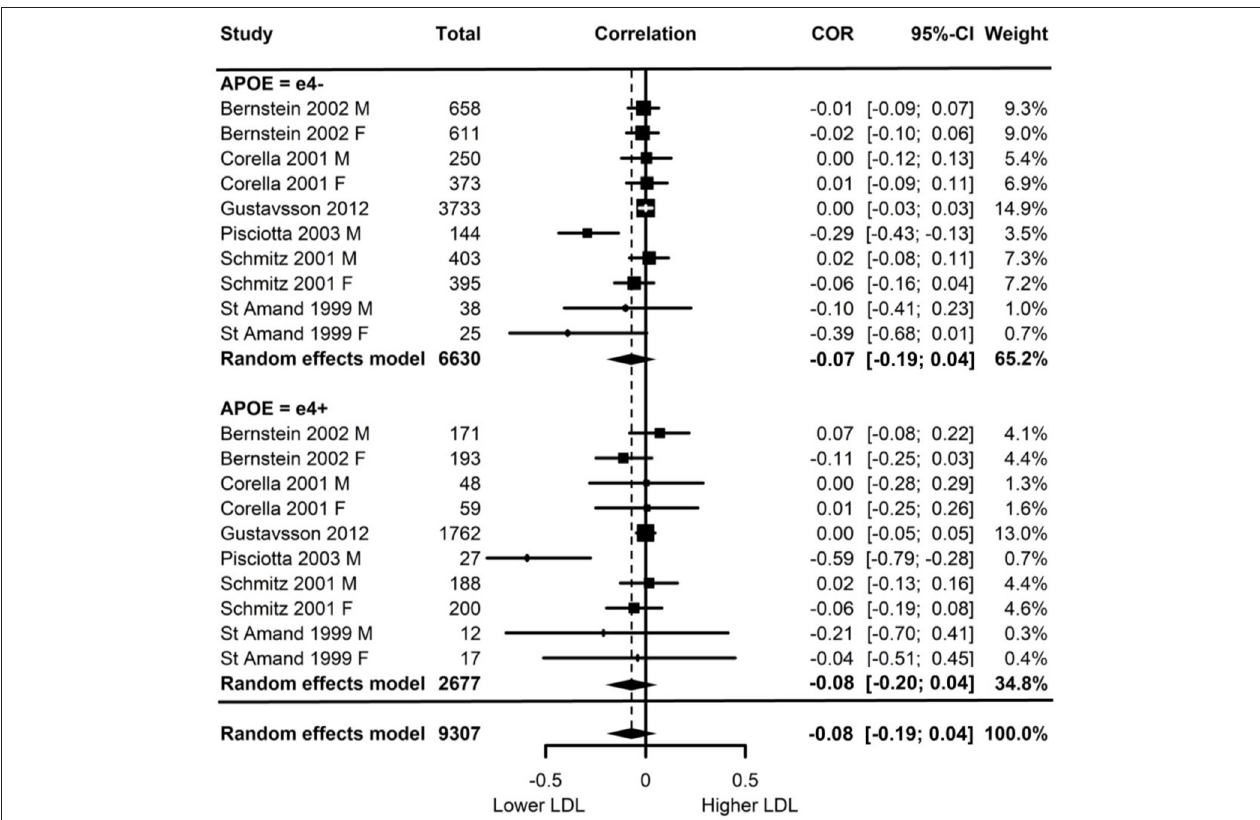
FIGURE 2 | Forest plot indicating the association between physical activity and LDL with carrier (e4 + ) and non-carrier (e4–) subgroups. Subgroup moderation test indicated no significant difference between APOE groups ( p = 0.84).